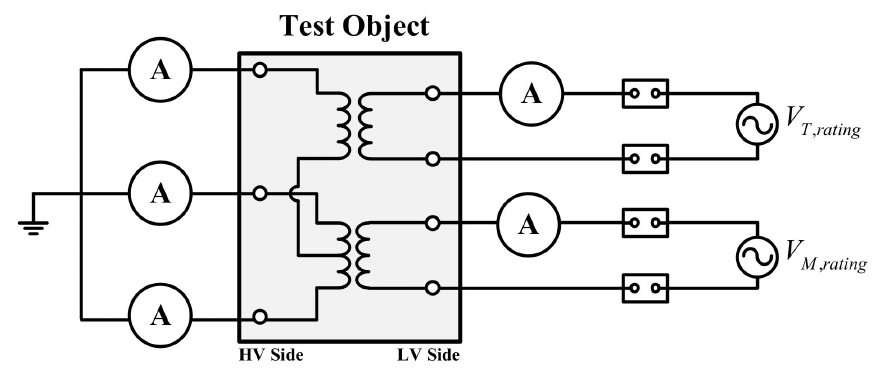
Figure 12. Circuit diagram for short-circuit test of the Scott transformer.